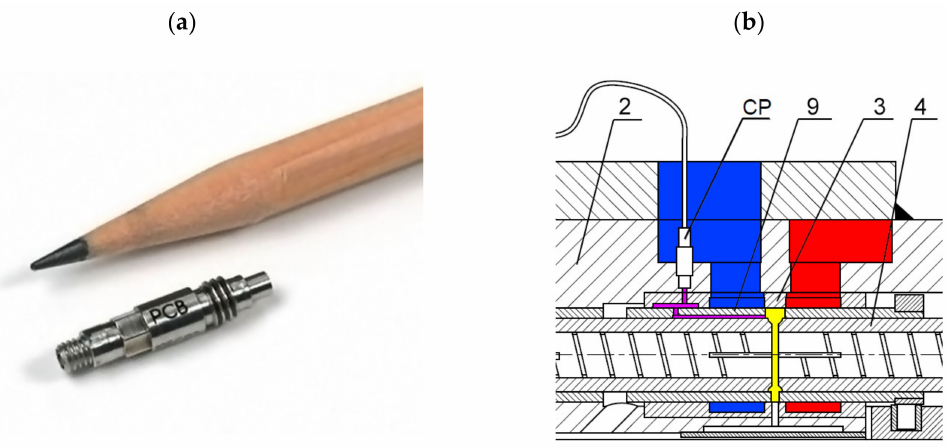
Figure 9. Piezoelectric pressure sensor and its localization inside the pump: 2—body; 3—socket; 4—piston; 9—commutation